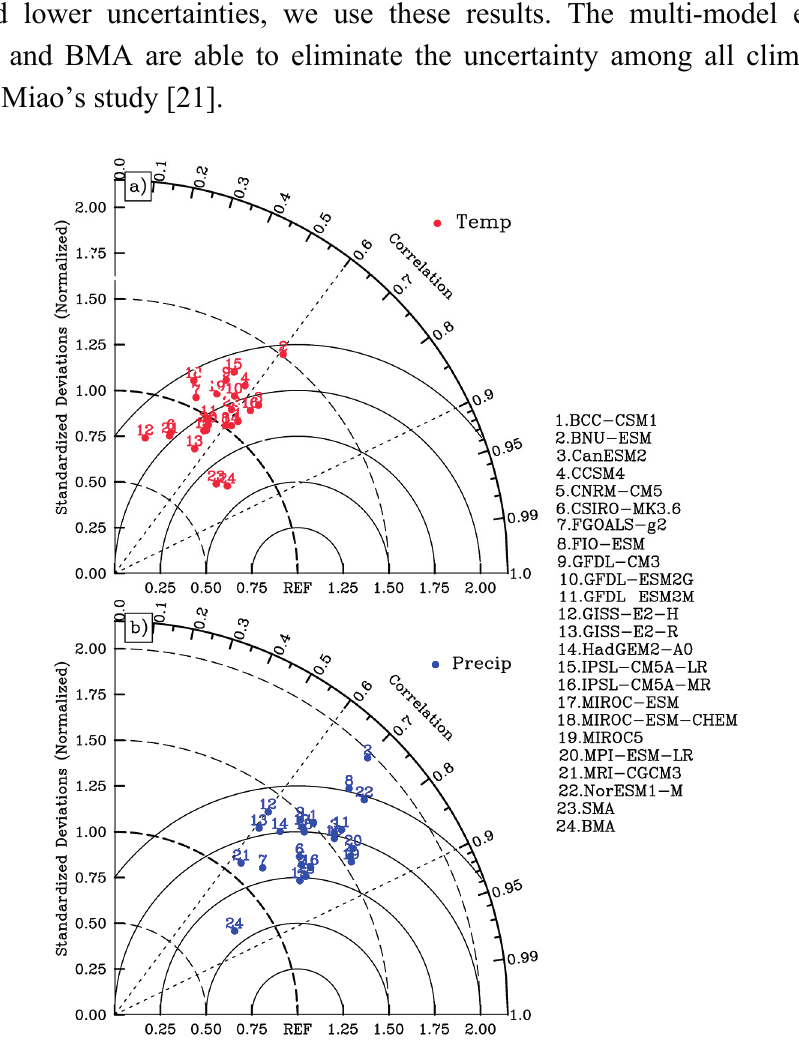
Figure 2. The accuracy of the modeled temperature ( a ) and precipitation ( b ) during the growing season, as evaluated by Taylor